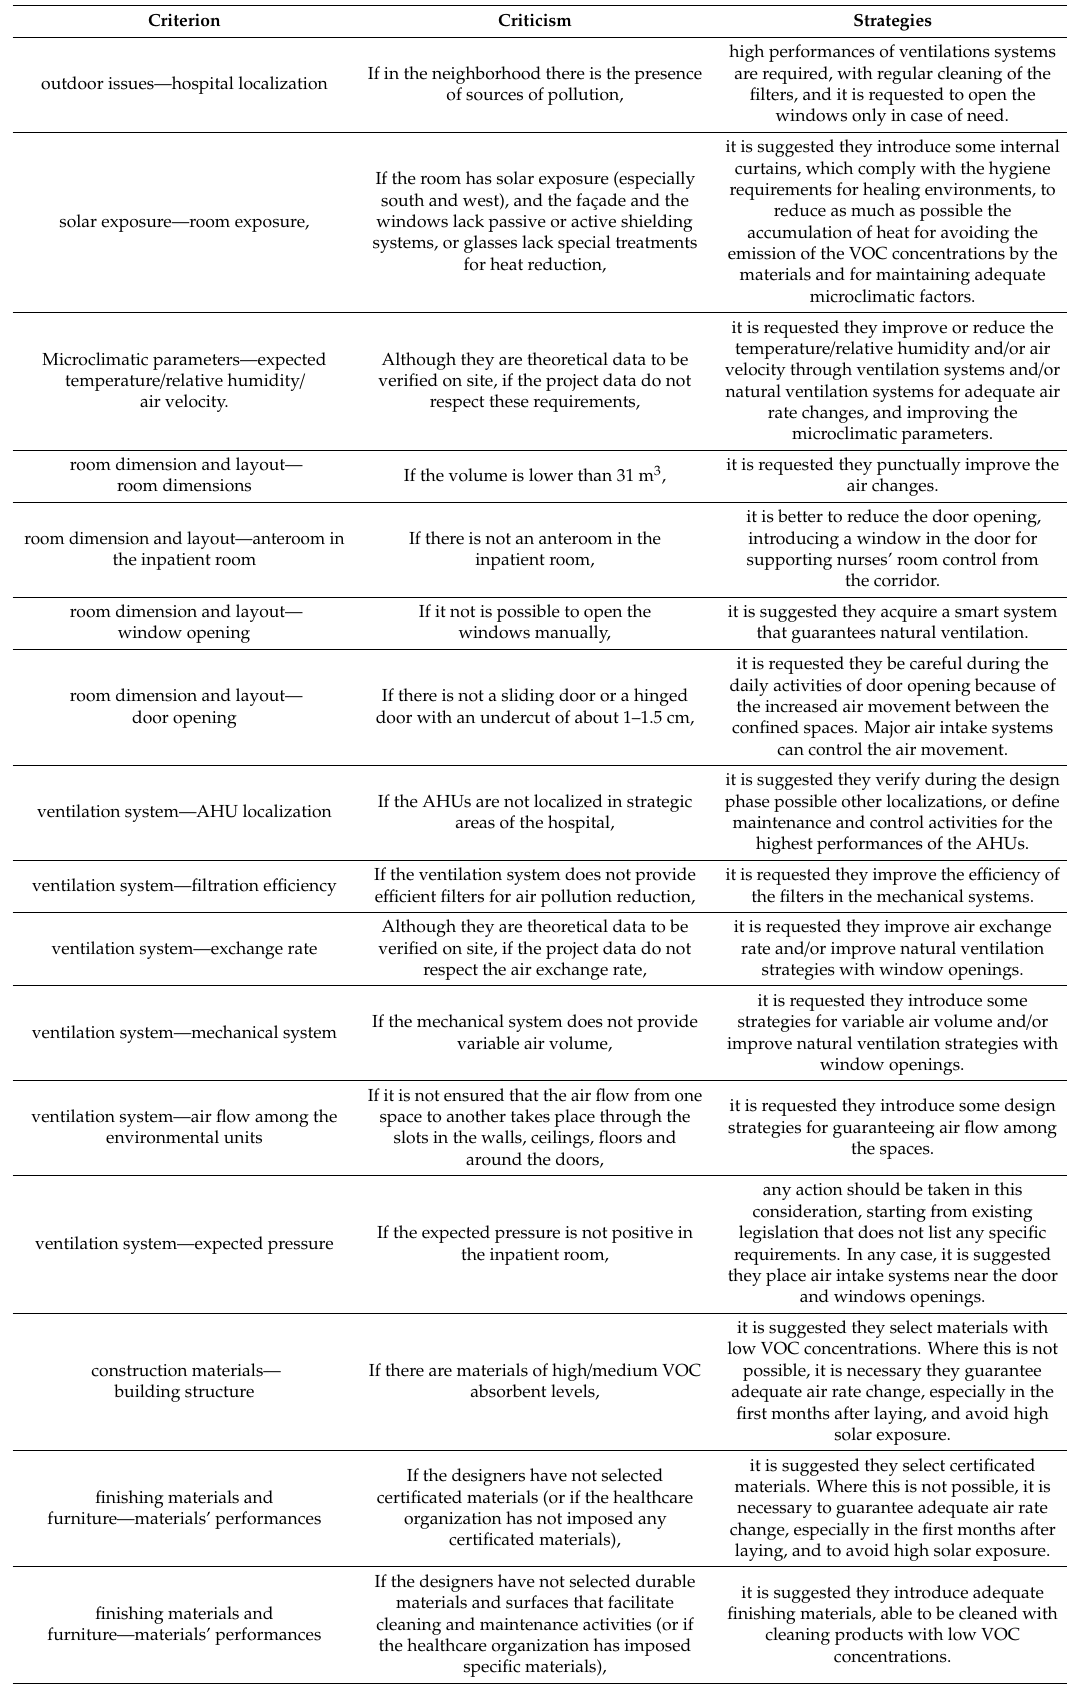
Table 2. Strategies for healthy outcomes of the